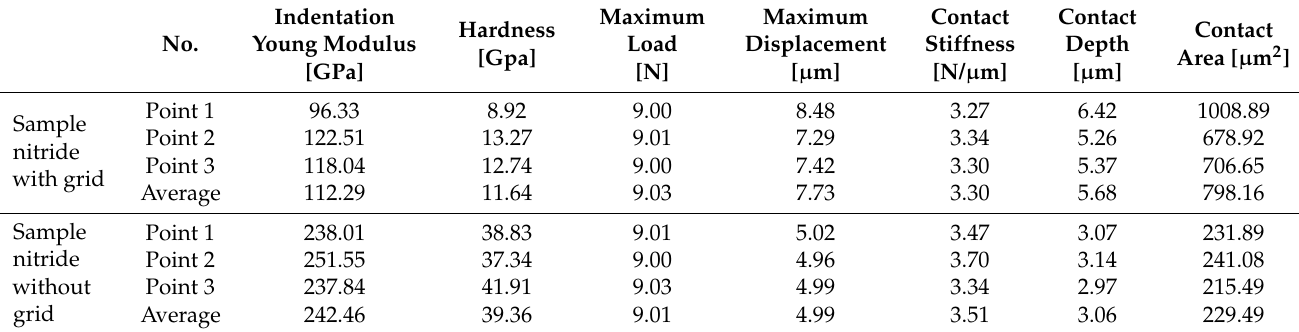
Table 8. The experimental result from micro indentation (three areas).